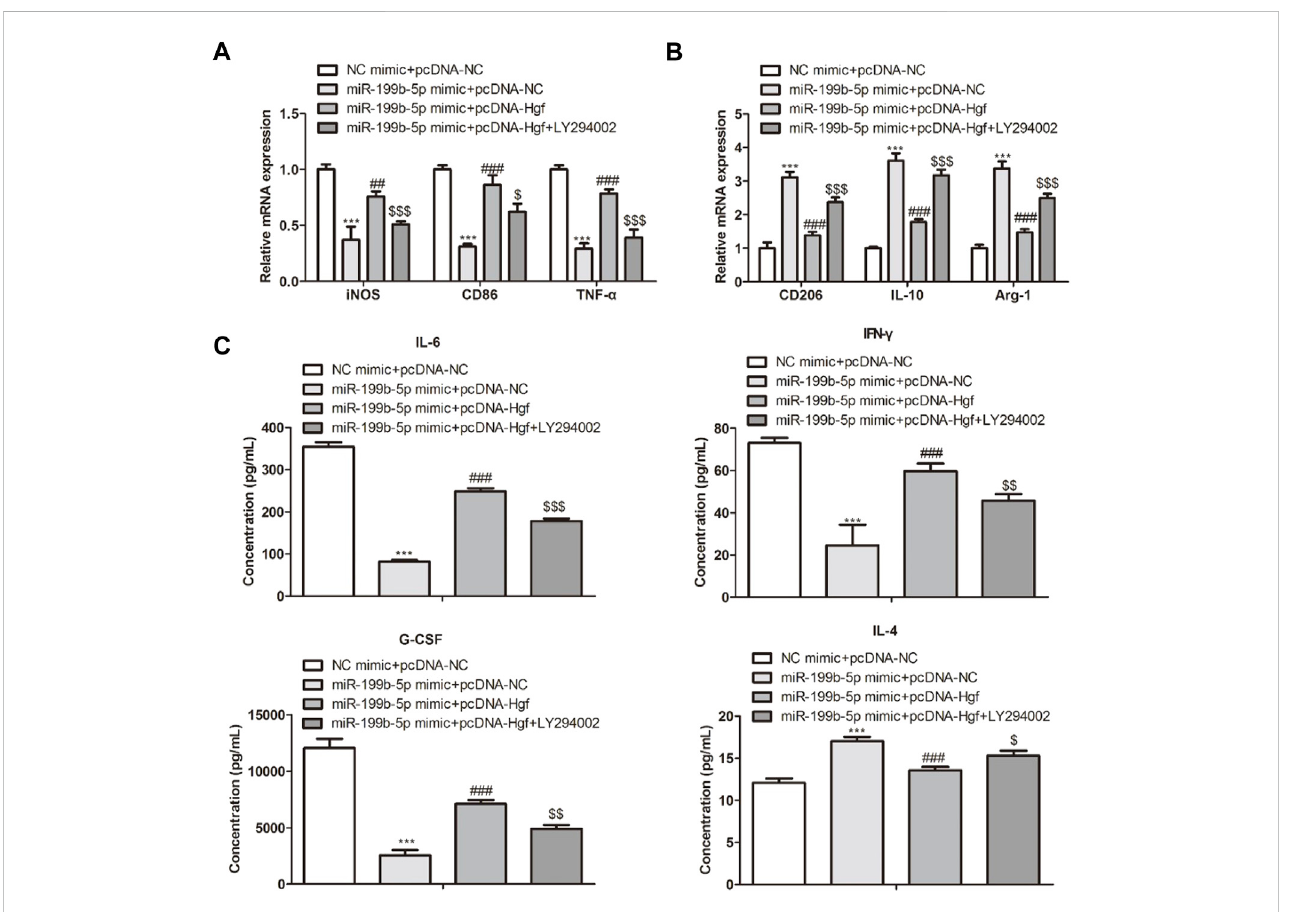
FIGURE 7 MiR-199b-5p regulated macrophage polarization via regulating Hgf and PI3K signaling pathways. (A) RT-qPCR showed M1 marker expression (iNOS, CD86andTNF- α ). (B) RT-qPCRrevealedM2markerexpression(CD206,IL-10,andArg1). (C) ELISAshowedtheconcentrationofIL-4,IL-6, IFN- γ ,andG-CSF. *** p < .001, ## p < .01, ### p < .001, $ p < .05, $$ p < .01, $$$ p < .001 vs. NC mimic +